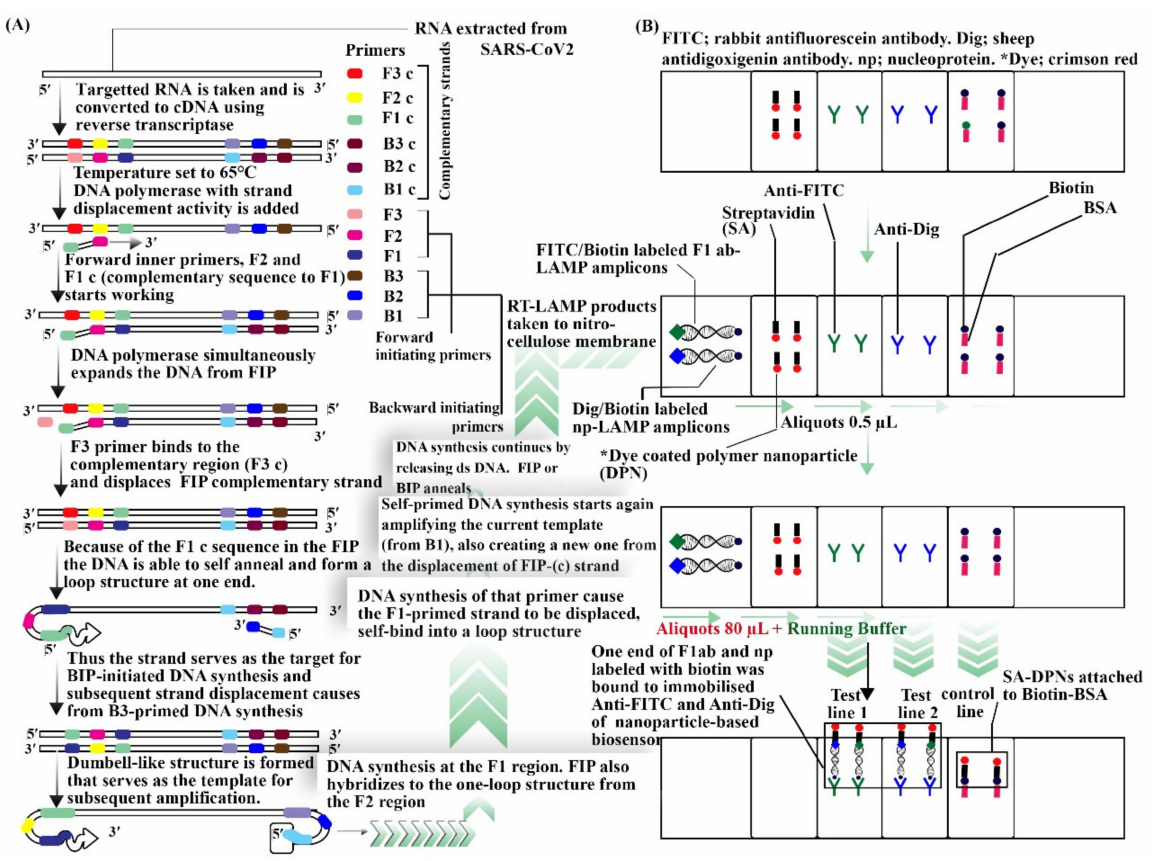
Figure 6. RT-LAMP NBS procedure and working diagram. ( A ) Procedure for reverse transcription loop mediated isothermal amplification. ( B ) Nanoparticles-based biosensor. This diagram was drawn from